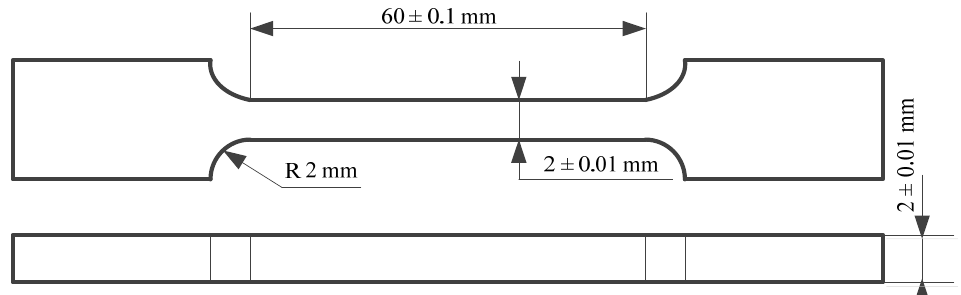
Figure 1. The shape of the samples used to perform the tensile test.